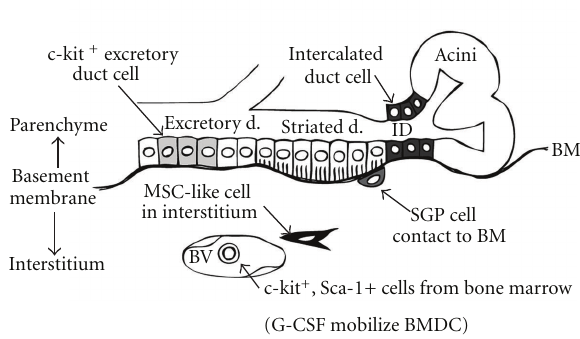
Figure 2: Tissue location of salivary gland stem/progenitor cells. ID cells (dark grey) and c-kit-positive excretory duct cells (light grey) are parenchymal cells that rest on the basement membrane (BM). Bone-marrow-derived cells are present in the blood vessel, and MSC-like cells (black) in the interstitium, but they are not in contact with the BM. On the other hand, SGP cells (grey) do not rest on the BM, but are in contact with the BM. Abbreviations: BM: basement membrane; BV: blood vessel; ID: intercalated duct; d.: